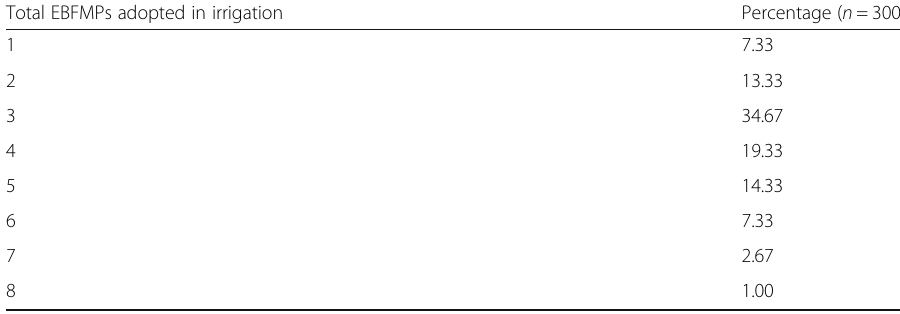
Source: Field survey,